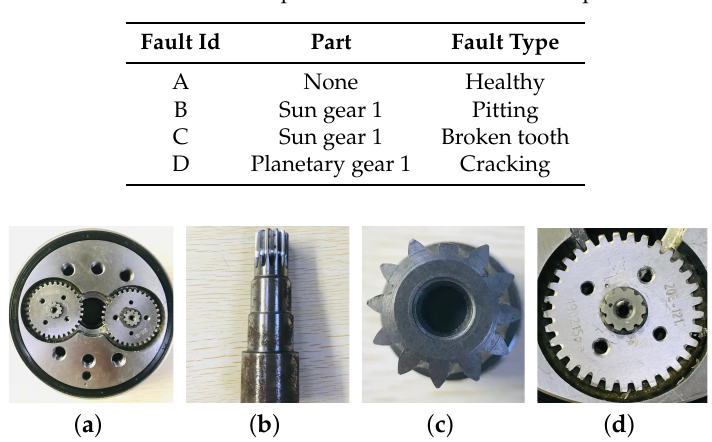
Figure 8. Examples of each one of the 4 monitoring conditions: ( a ) Healthy state; ( b ) Pitting in Sun gear 1; ( c ) Broken tooth in Sun gear 1; and ( d ) Cracking in Planetary gear